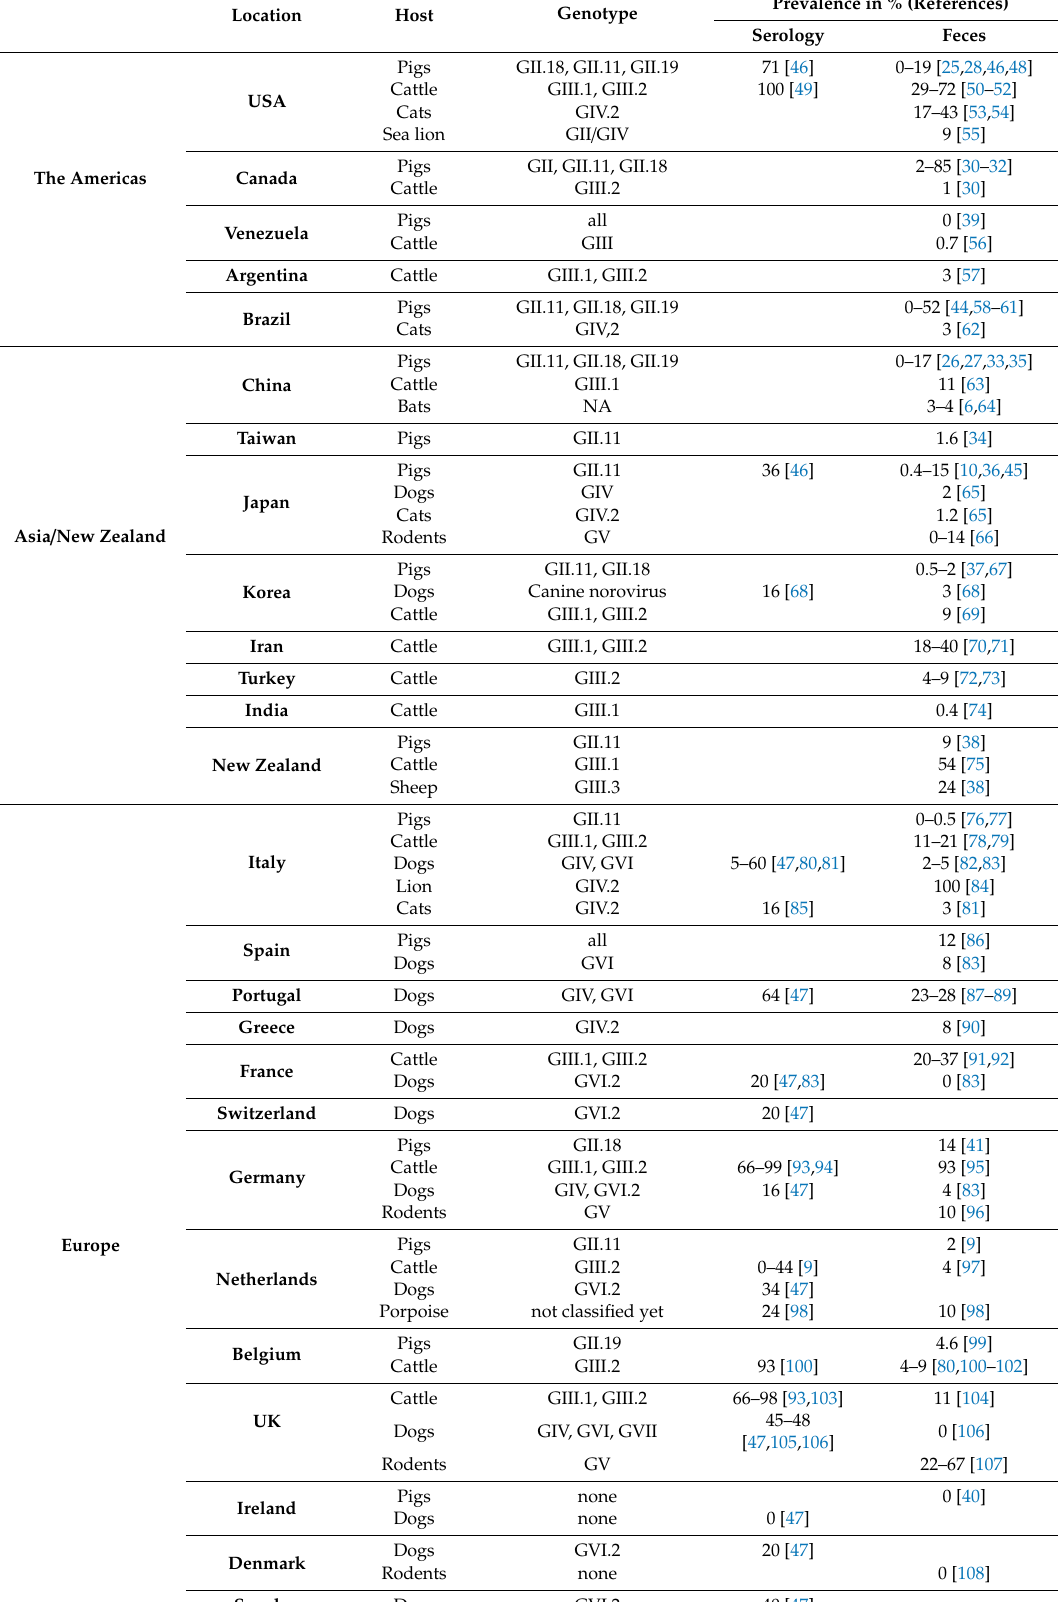
Table 1. Summary of studies detecting animal norovirus in animals, either in feces or by serology. Details of each study can found in Supplementary Table